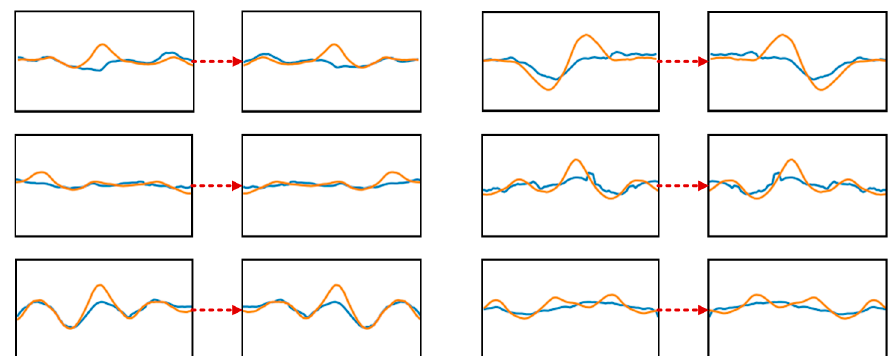
Figure 9. Data augmentation through horizontal flipping.